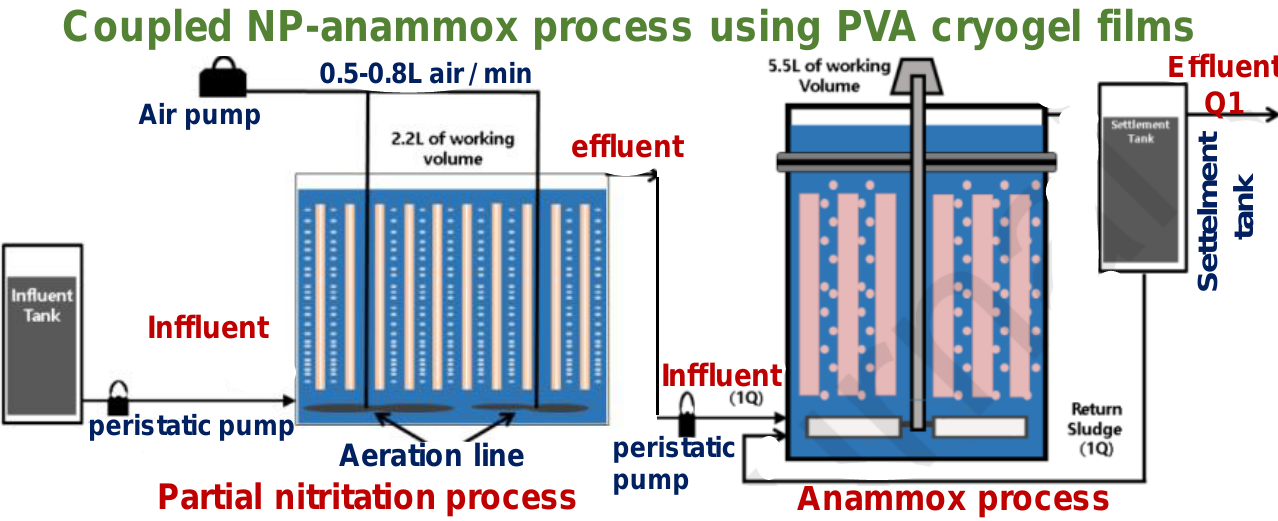
Figure 5. Experimental setups for continuous flow fixed-bed bioreactors (FBBRs) with flat-type PVA cryogel film [98] adapted with permission from Elsevier.